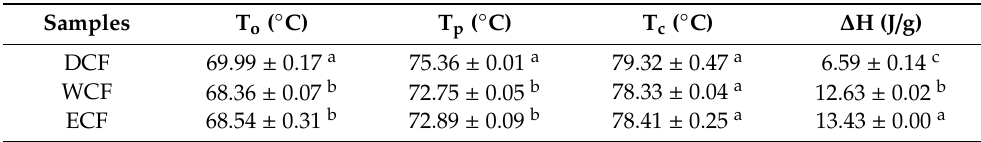
Table 3. Thermal properties of corn